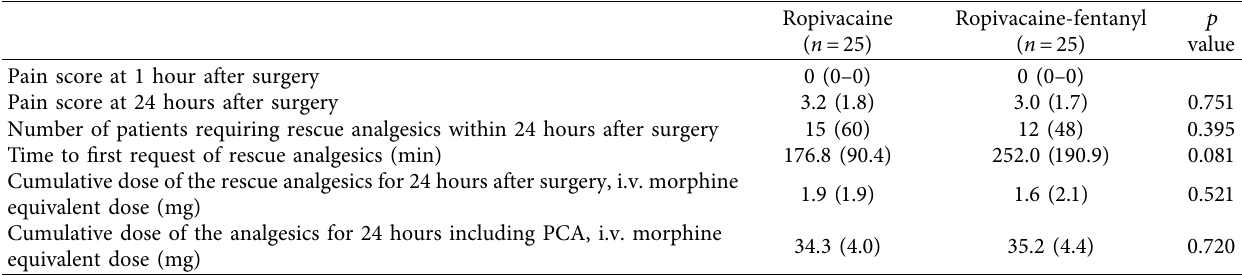
Table 4: Postoperative pain and requests of rescue